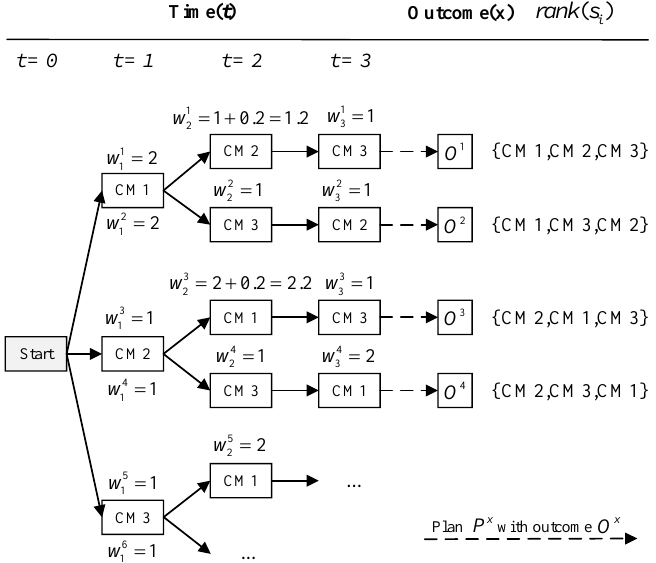
Figure 13. The first search tree with BR from time step t = 0; the plan P 1 is chosen as the initial